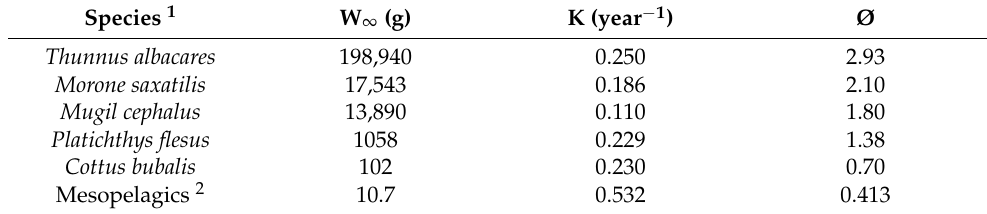
Table 2. Comparison between the growth performance of mesopelagic fishes with that of other teleosts using the growth performance index Ø = log(K) + (2/3)log(W ∞